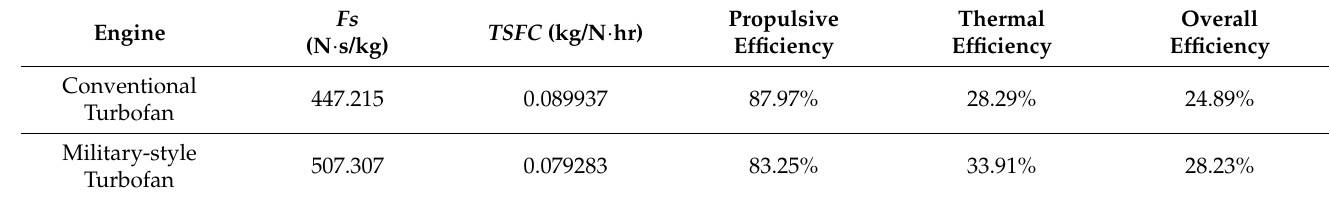
Table 4. Performance with Bypass Ratio Fixed at